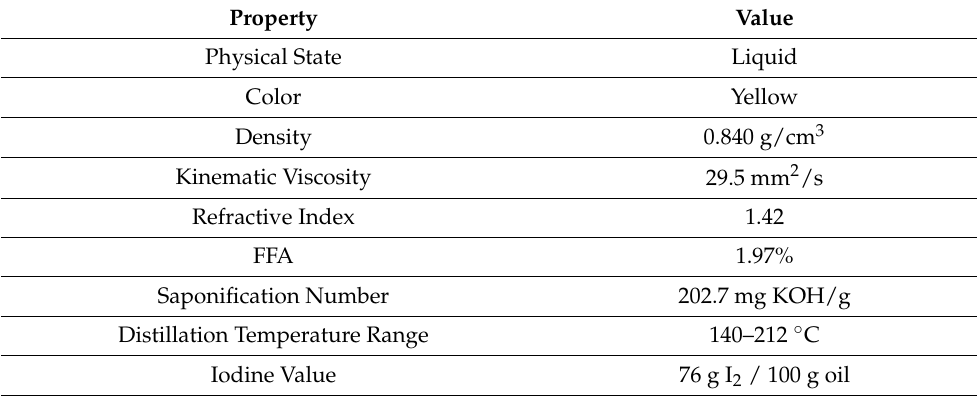
Table 3. Physicochemical properties of T. indica seed